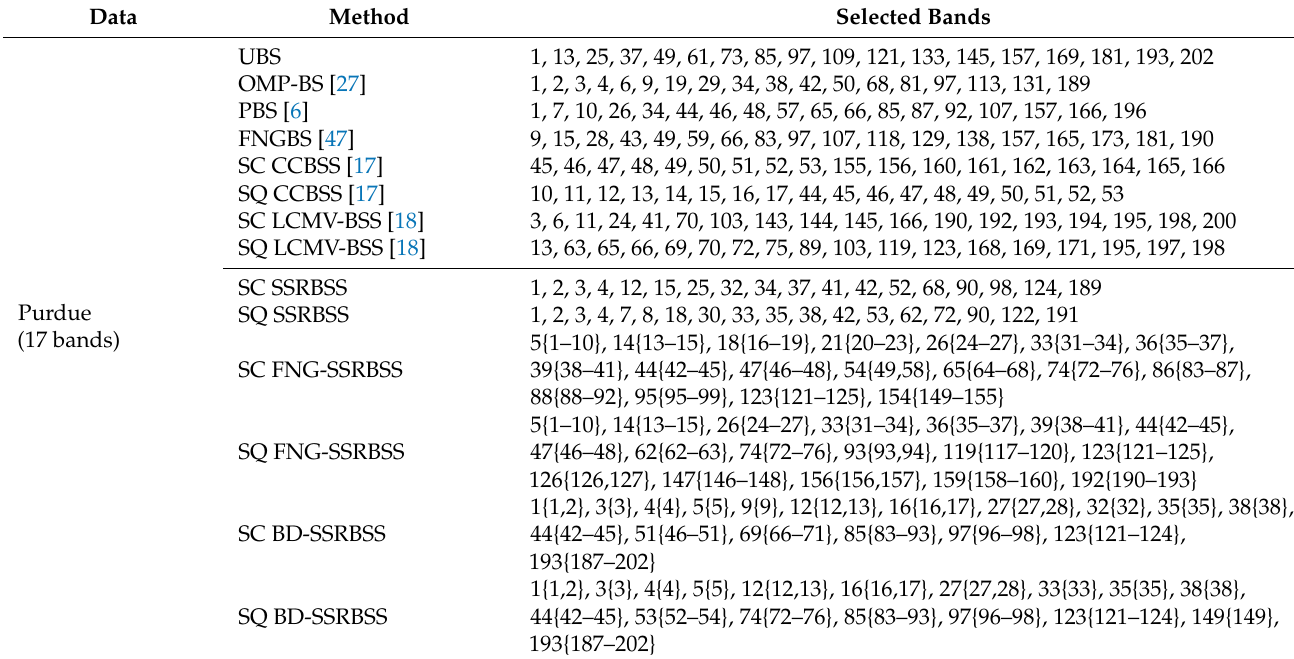
Table 4. The bands selected by the proposed and the compared methods for the Purdue